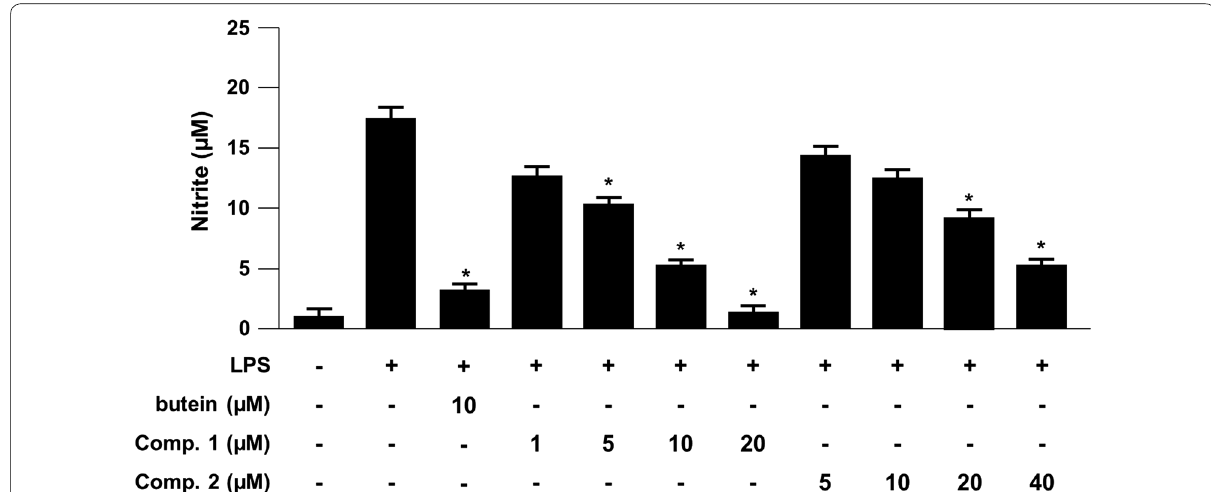
Fig. 1 Inhibitory activity of 1 and 2 on NO generation in RAW 264.7 induced by LPS. The cells were pretreated for 12 h with the indicated concentrations of compounds and stimulated for 18 h with LPS (1 µg/mL). The error bars represent the mean experiments. * p < 0.05 compared to the LPS‑treated control group. Positive control,